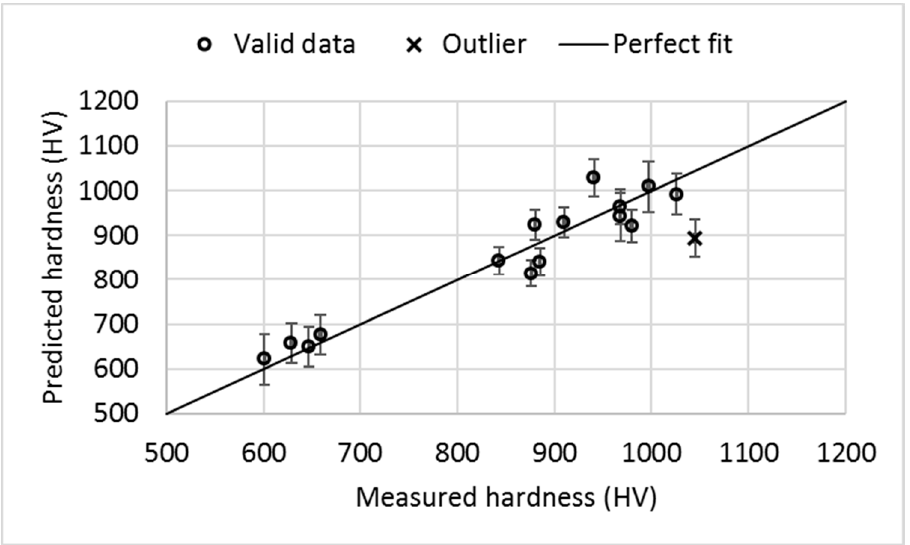
Figure 6. Predicted vs. measured hardness with the ground sample data set.